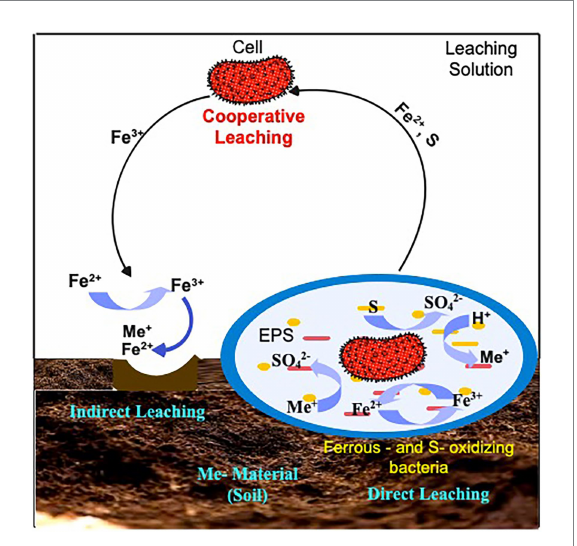
FIGURE 1 Schematic representation of the autotrophic leaching mechanisms: Contact (Direct): microorganisms oxidizing metal sulfides using a variety of enzymatically catalyzed processes; Non-contact (Indirect): the use of Fe 3+ to cause oxidation of metal sulfides and reduced to Fe 2+ and Cooperative leaching: Sulfur and heavy metals undergoing dissolution by means of planktonic